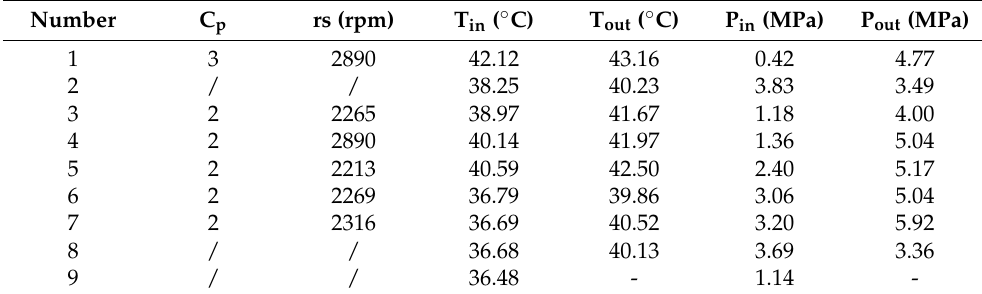
Table 8. MASSA simulation operation